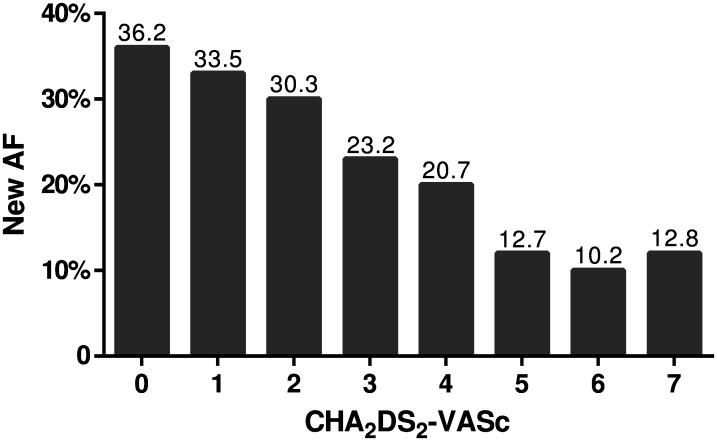
New AF diagnoses at the time of ischemic stroke according to CHA2DS2-VASc score.CHA2DS2-VASc score is calculated at the time of the ischemic event and scoring does not include the current event. N = 2,914 (score 0: N = 38; score 1: N = 64; score 2: N = 127; score 3: N = 155; score 4: N = 163; score 5: N = 64; score 6: N = 21; score 7: N = 5). Abbreviations: AF, atrial fibrillation.